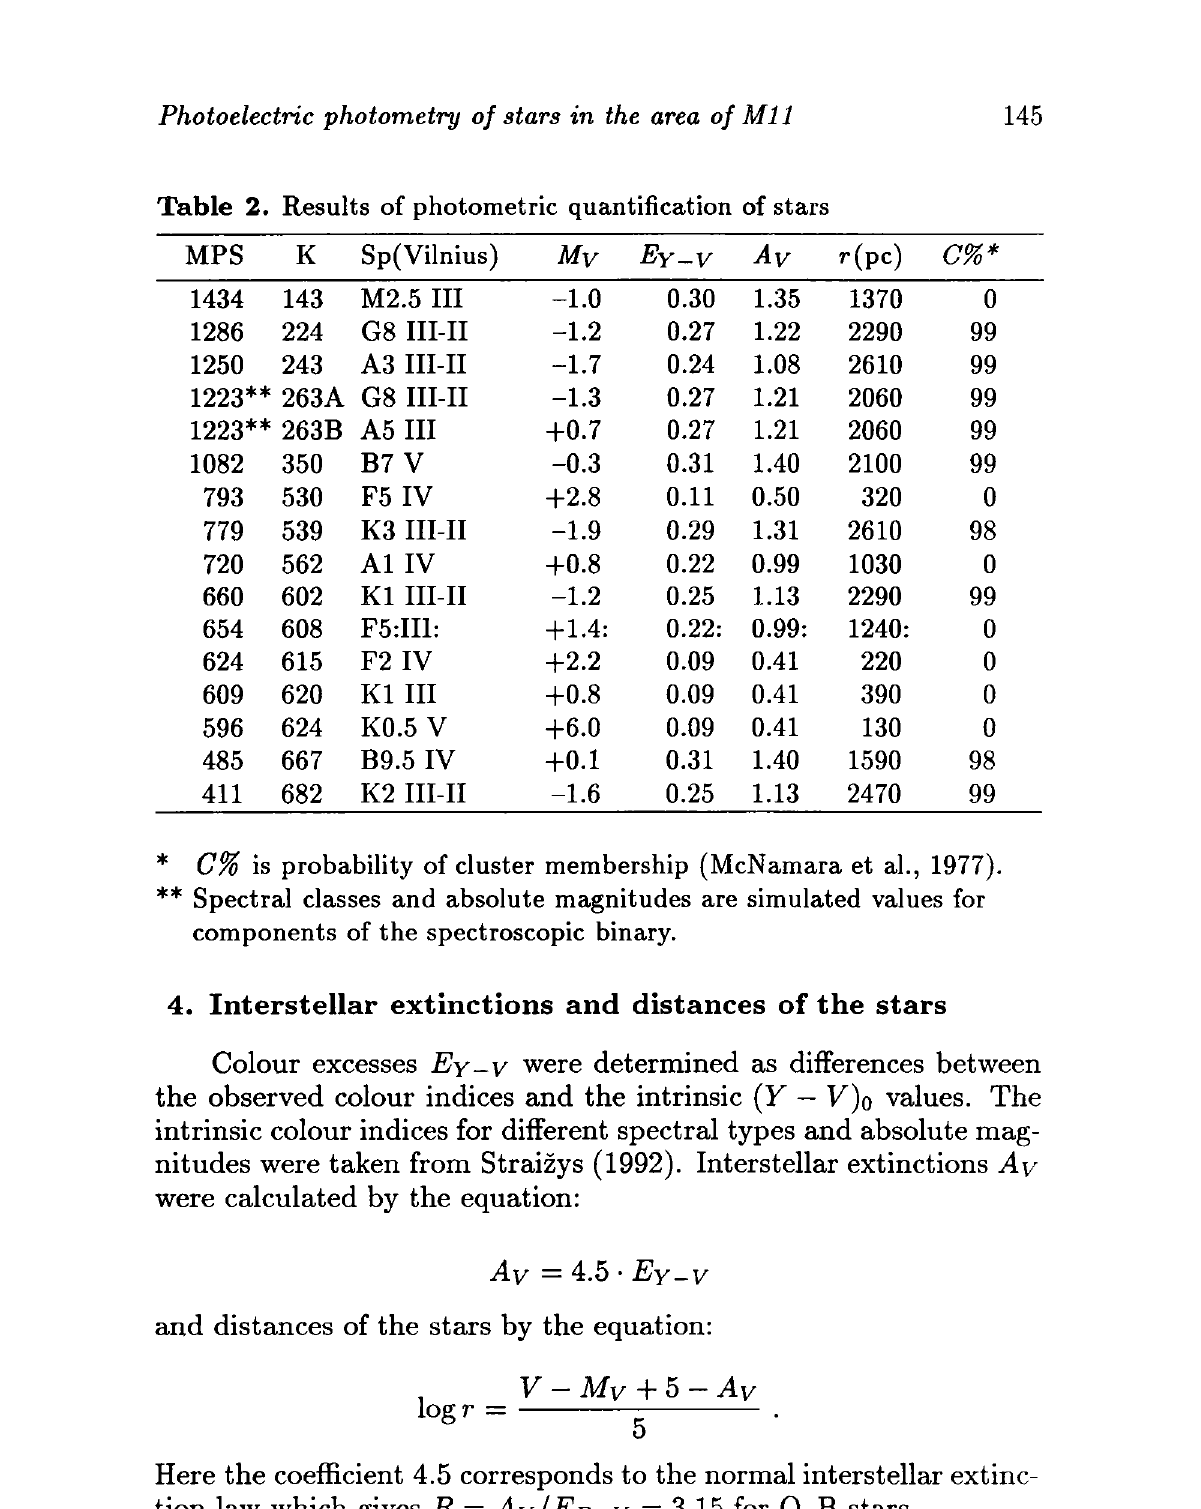
Table 2. Results of photometric quantification of stars